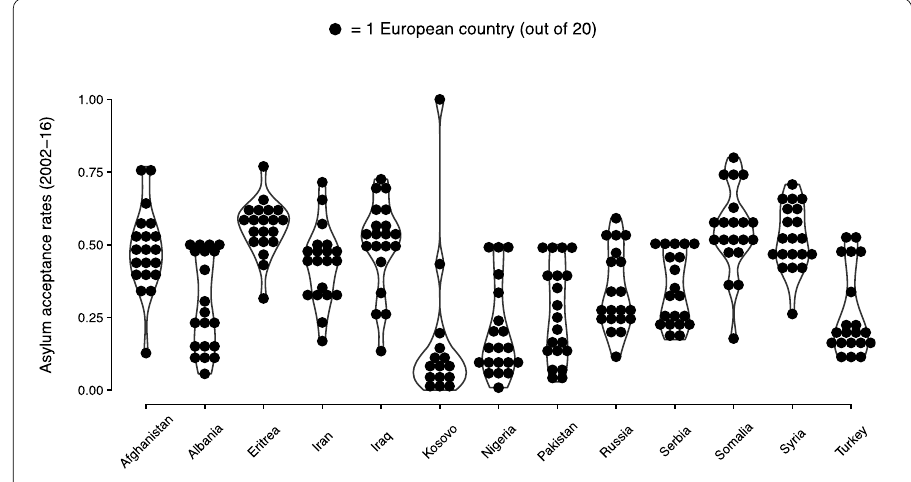
Figure 2 Cross sectional variation in asylum acceptance rates across Europe. The x -axis lists the top-15 countries who submitted asylum applications in Europe from 2002–16 (in alphabetical order). Each black dot represents 1 (out of 20) European countries in our study